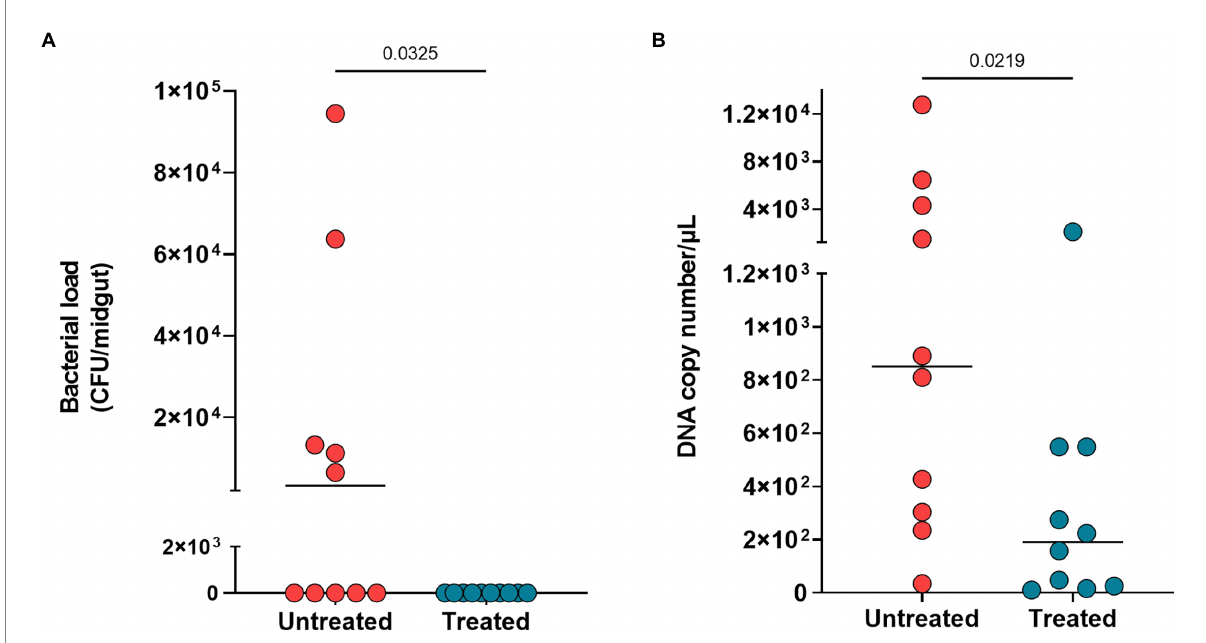
FIGURE 2 Midgut microbiota reduction after three days of antibiotic treatment. (A) Bacterial load of plated midguts untreated mosquitoes (red circles) and treated mosquitoes (blue circles). (B) DNA copy number per microliter of midgut from untreated and treated mosquitoes. Each circle represents midgut analyzed, and horizontal black bars represent the median value. The Mann Whitney test was used to determine significance for differences in reduction of bacterial load and DNA copy